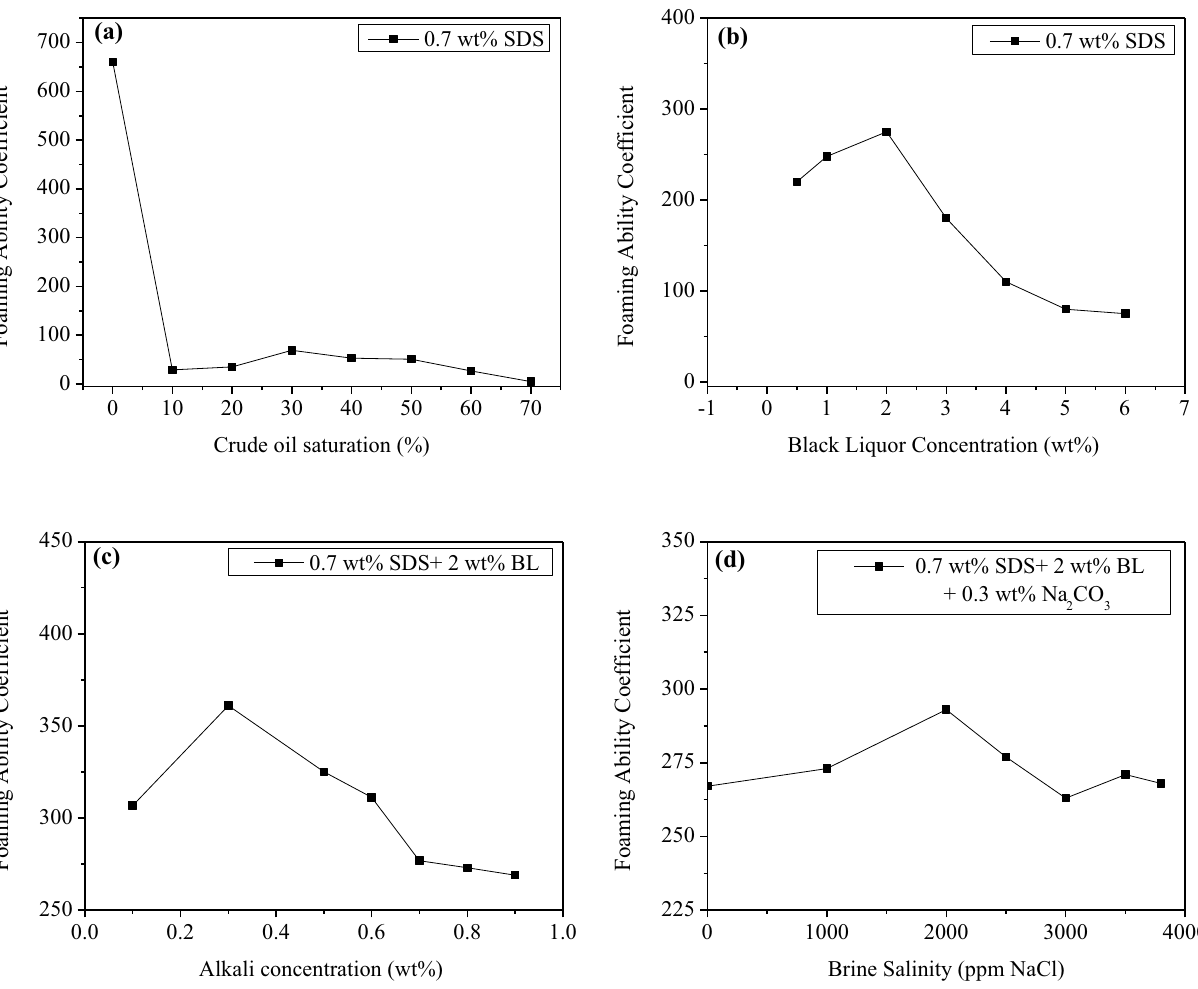
Fig. 3 Effect of a crude oil saturations, b black liquor concentration, c alkali concentration, d brine salinity on foaming ability